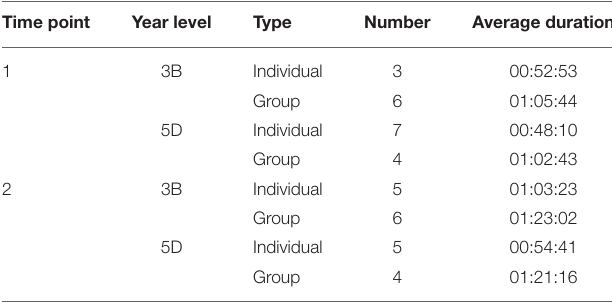
TABLE 2 | Average interview duration according to study time point, year level of participants, and type (individual or group). Time point